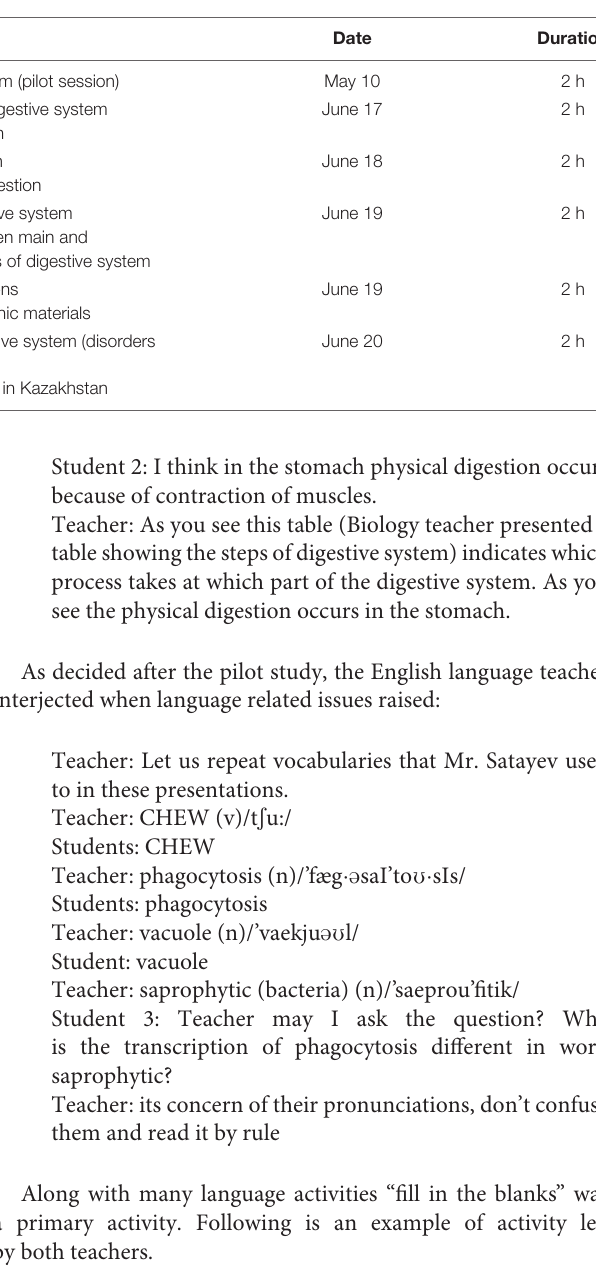
TABLE 1 | Daily schedule for CLIL